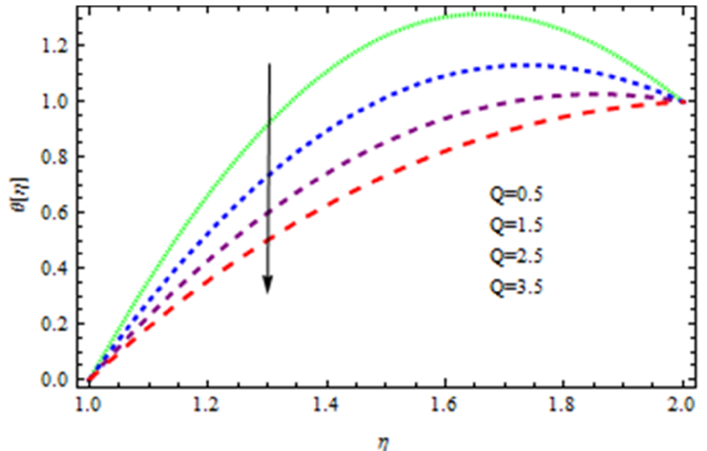
Figure 17. Temperature distribution in the Reynolds model for Q.